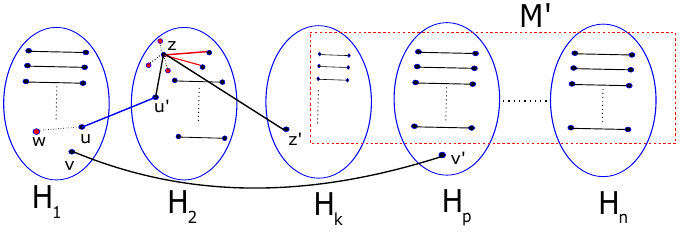
Figure 4: Case 2.2.2.1: | F V